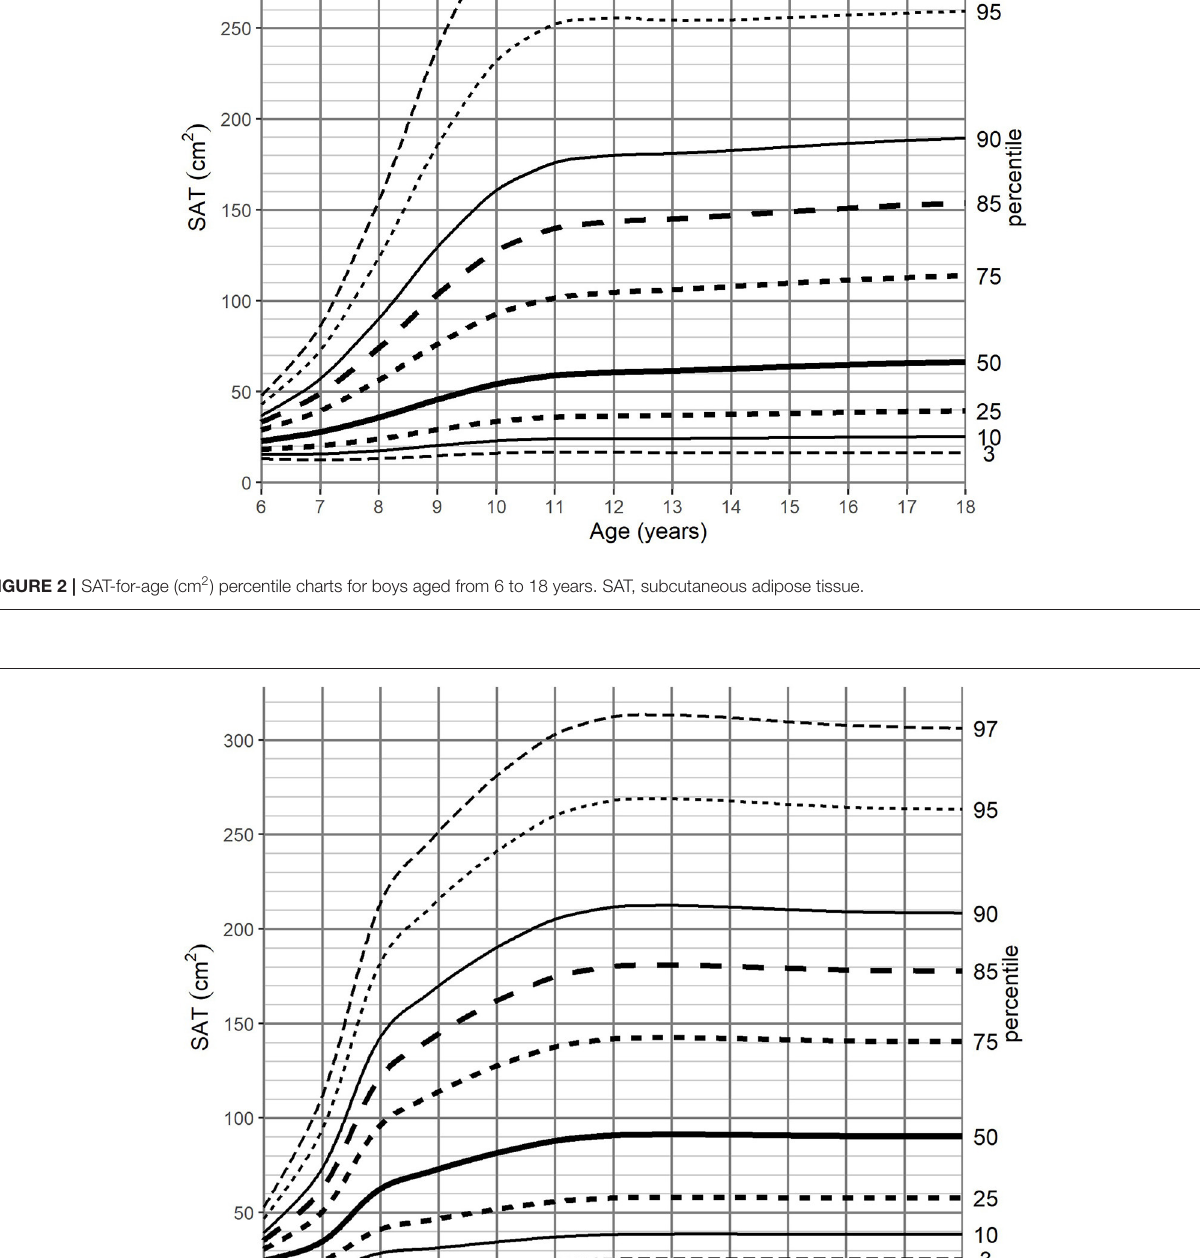
Frontiers in Nutrition |